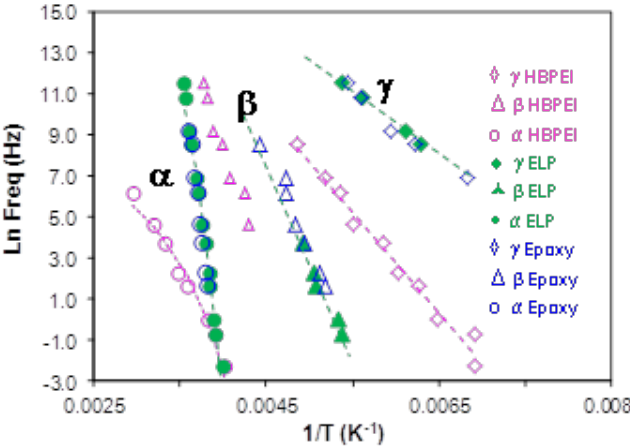
Figure 9. Relaxation map for the epoxy, HBPEI and ELP systems at 2 K/min. Blue open symbols, epoxy; pink open symbols, HBPEI; green symbols, ELP. Circles, α-relaxation; triangles, β-relaxation; rhombus, γ-relaxation.